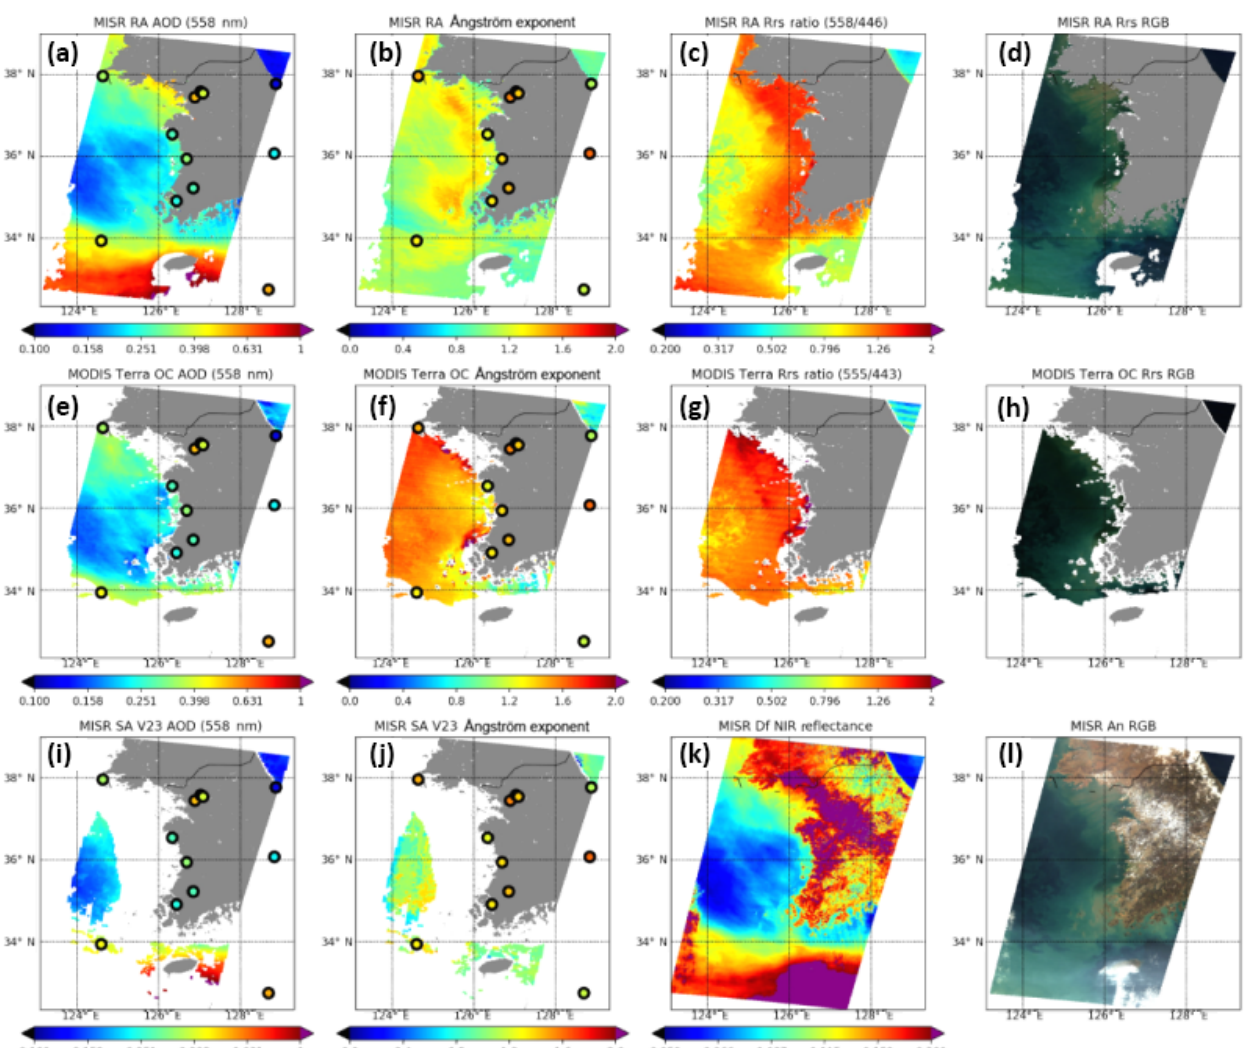
Figure 4. Same as Fig. 1, except for the optically diverse waters of the Yellow Sea. MISR imagery acquired on 13 March 2012, 02:30Z: Terra Orbit 65076, blocks 60–64. Coincident AERONET data were acquired as part of the Southeast-Asian leg of the DRAGON field campaign (colored circles). As most AERONET data are taken over land (some elevated), the data are not necessarily representative of the adjacent oceanic air